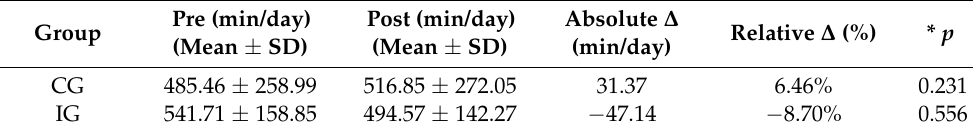
Table 4. Average daily exposure to sedentary behaviors in IG and CG before and after the intervention.